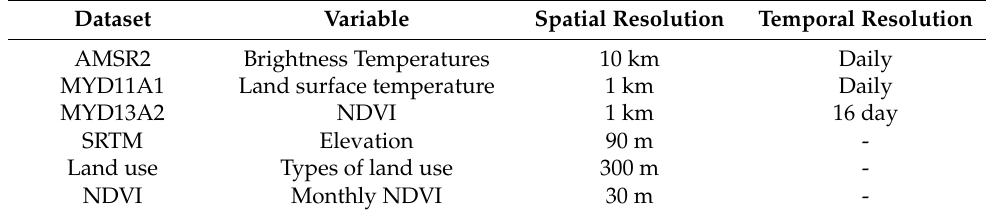
Table 1. Details of the data sets used in this study. Dataset Variable Spatial Resolution Temporal Resolution AMSR2 Brightness Temperatures 10